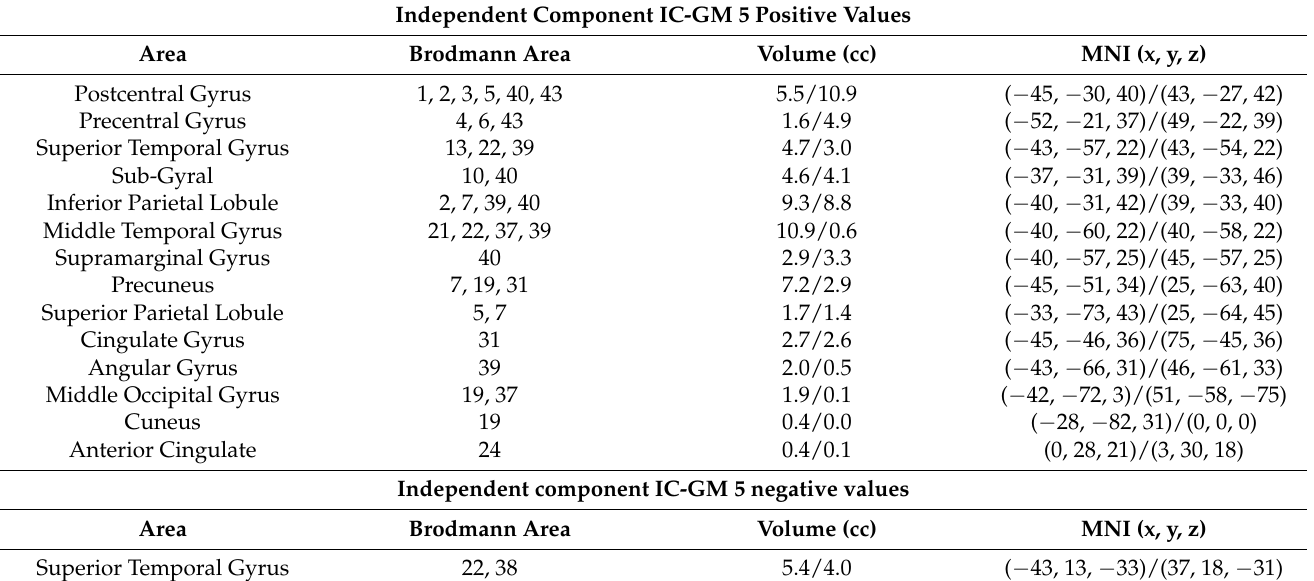
Table 2. Brain areas for each independent component, according to the Talairach